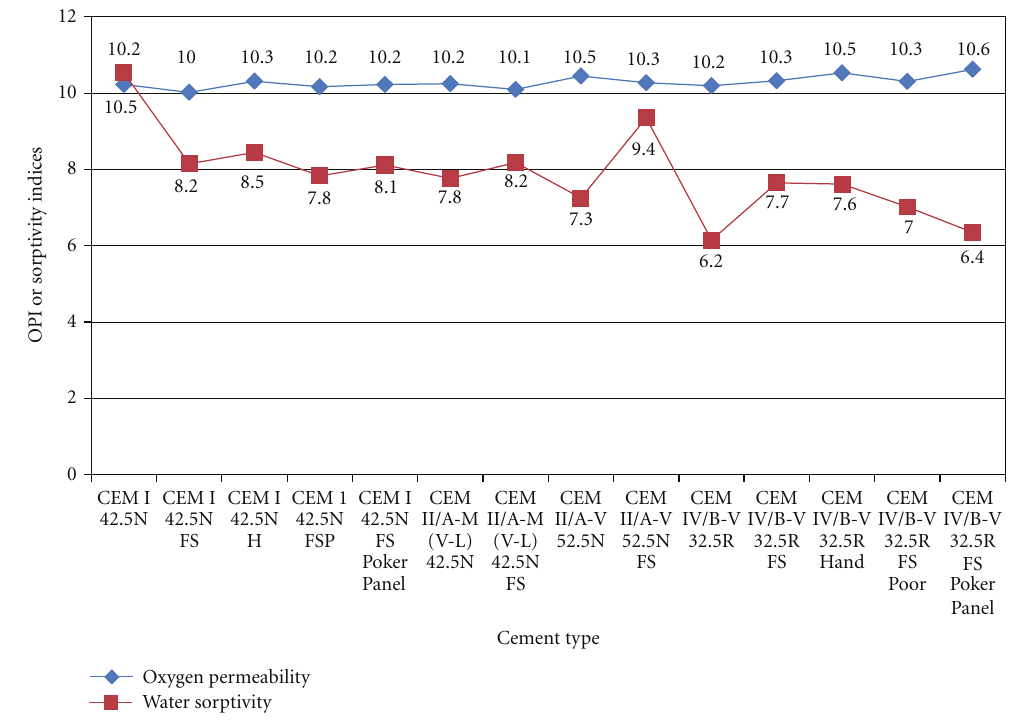
Figure 7: OPI and water sorptivity indices for di ff erent cement types at a w/c ratio of 0.5.